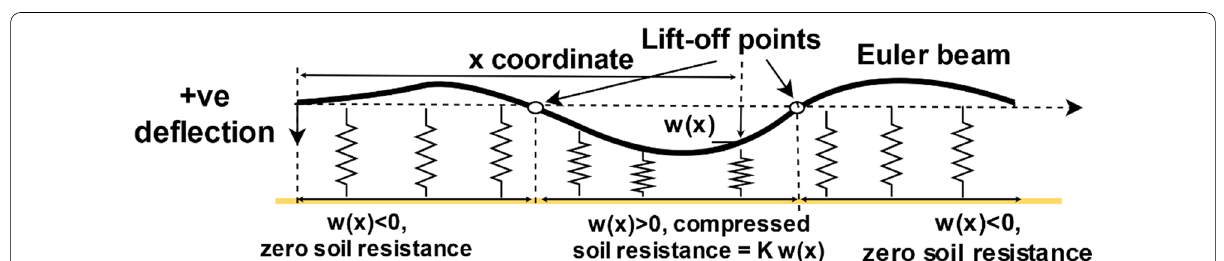
Fig. 2 A schematic of finite beam